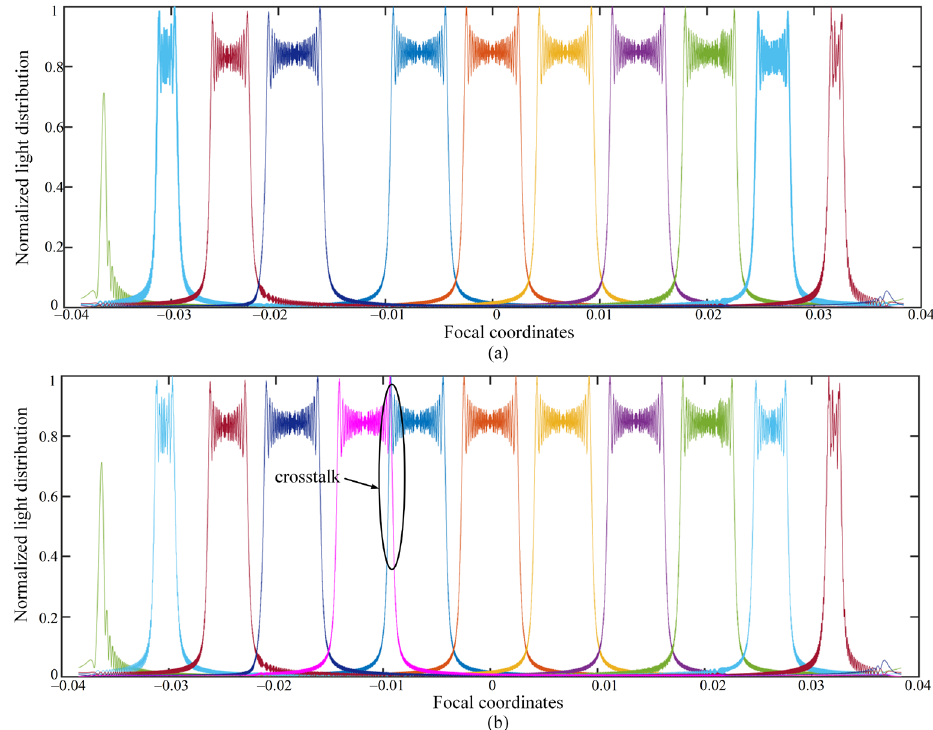
Figure 12. Normalized light distribution ( a ) for the eight perspectives, ( b ) for the nine perspec- tives.